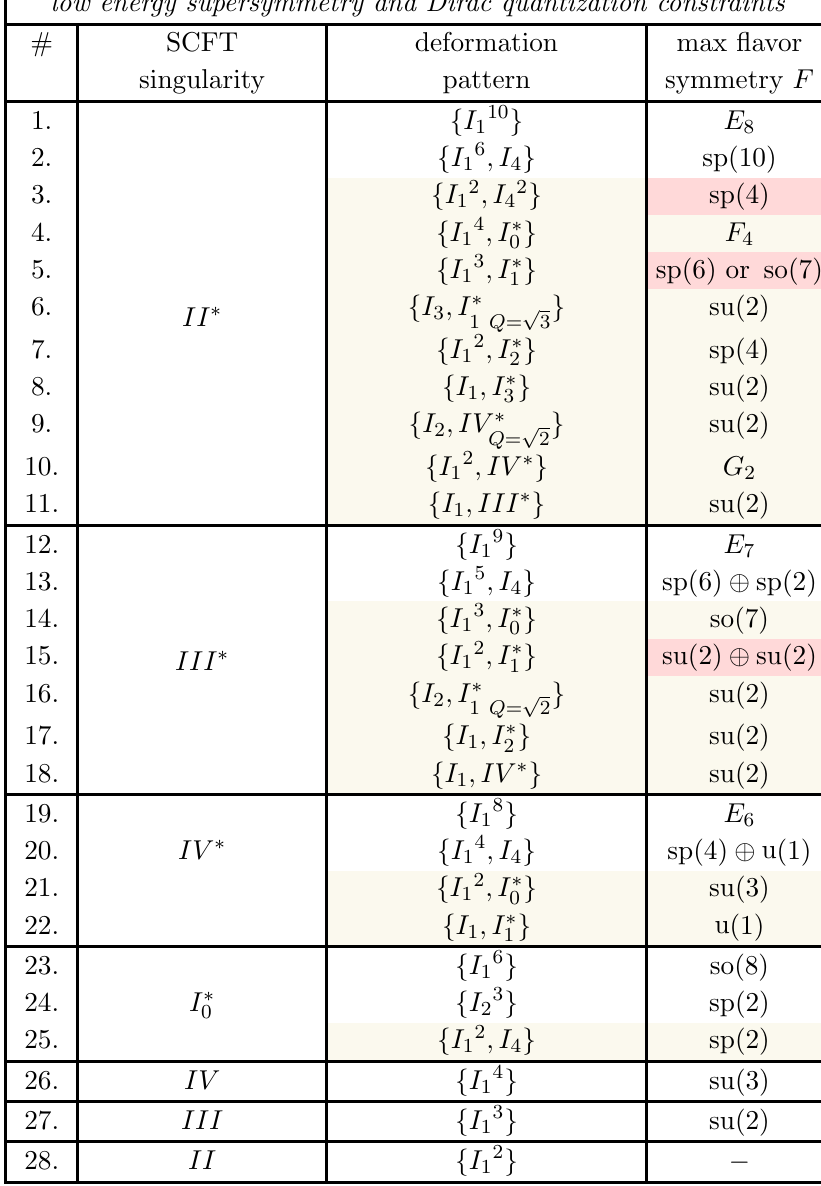
Table 1 . The 28 families of deformed planar rank-1 CB geometries consistent with the low energy Dirac quantization condition. Column 2 lists the Kodaira type of the scale invariant CB geometry, column 3 the resulting singularity types under a generic relevant deformation, and column 4 the maximal (cid:13)avor symmetry of the SCFT. The values for the central charges for the entries in the table are known and can be found in table 1 of